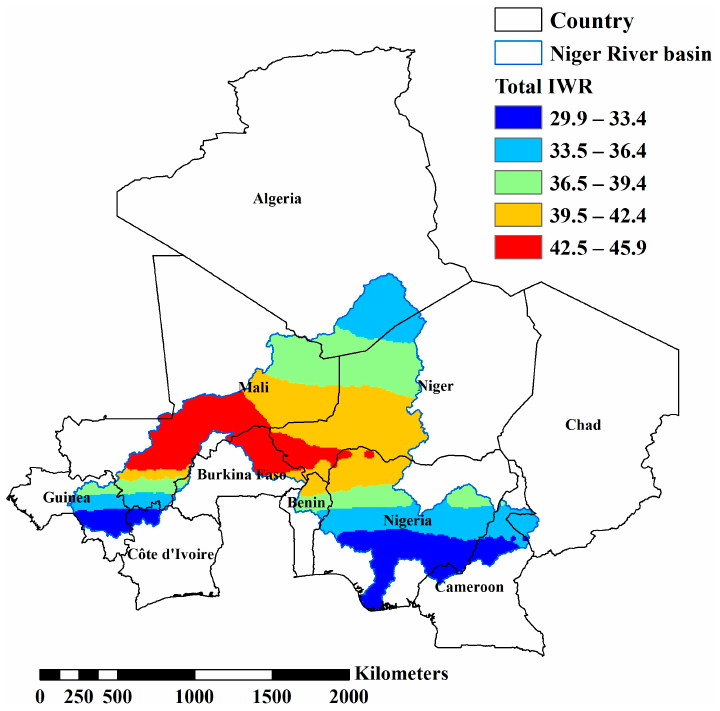
Figure 2. IRW under CSIRO. It shows the global irrigation water requirements in different countries in the basin under the RCP 4.5.